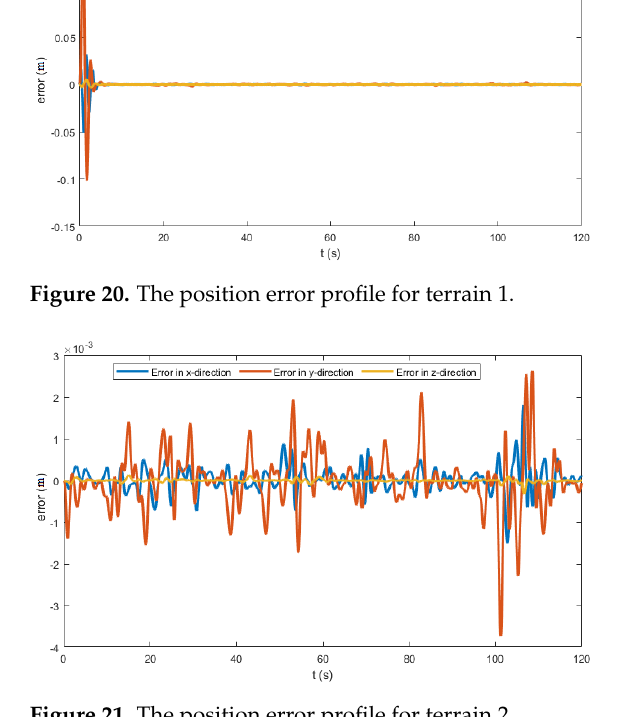
Figure 21. The position error profile for terrain